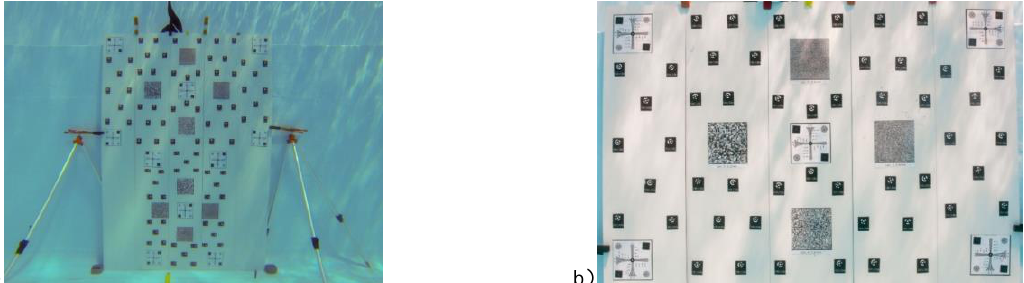
Figure 7. Test-field used in the swimming pool with stand with resolution and photogrammetric